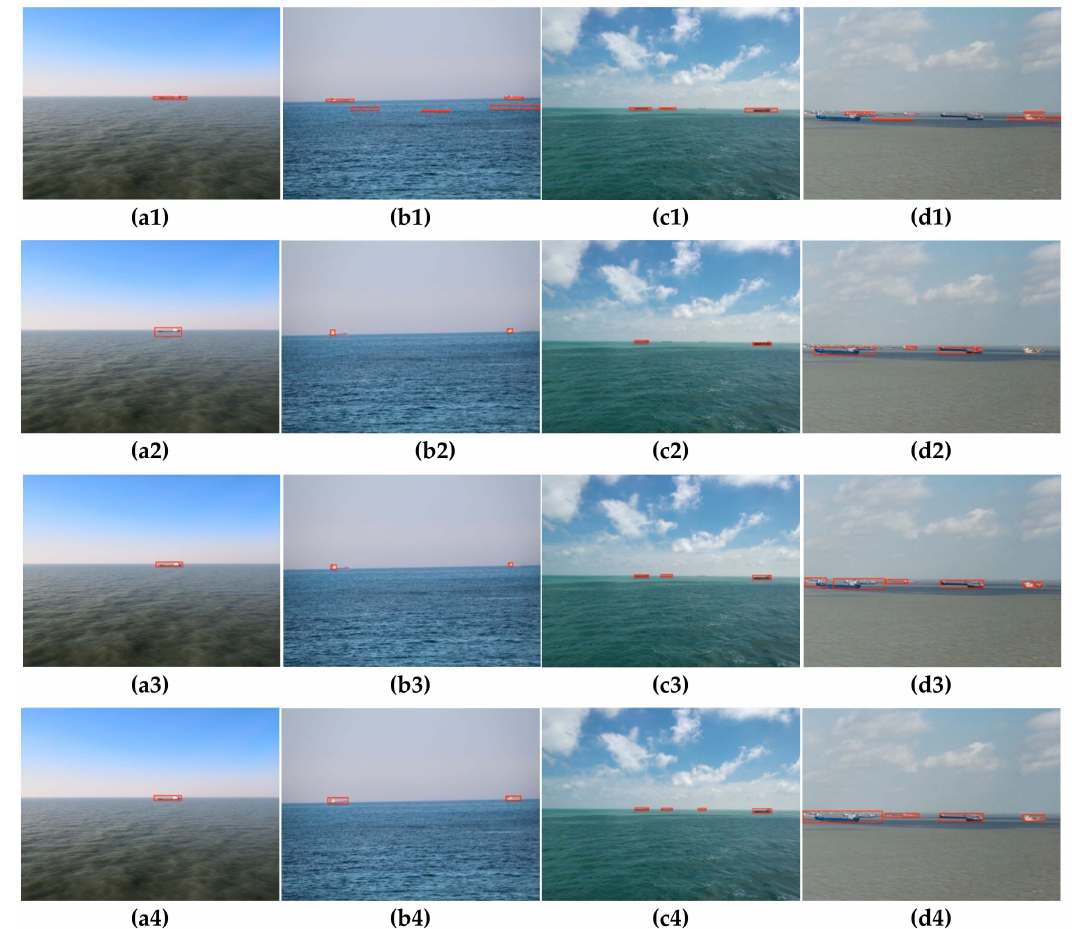
Figure 14. Object segmentation results by the four methods. ( a1 – d1 ) Object segmentation results by the SR method. ( a2 – d2 ) Object segmentation results by the RBD method. ( a3 – d3 ) Object detection results